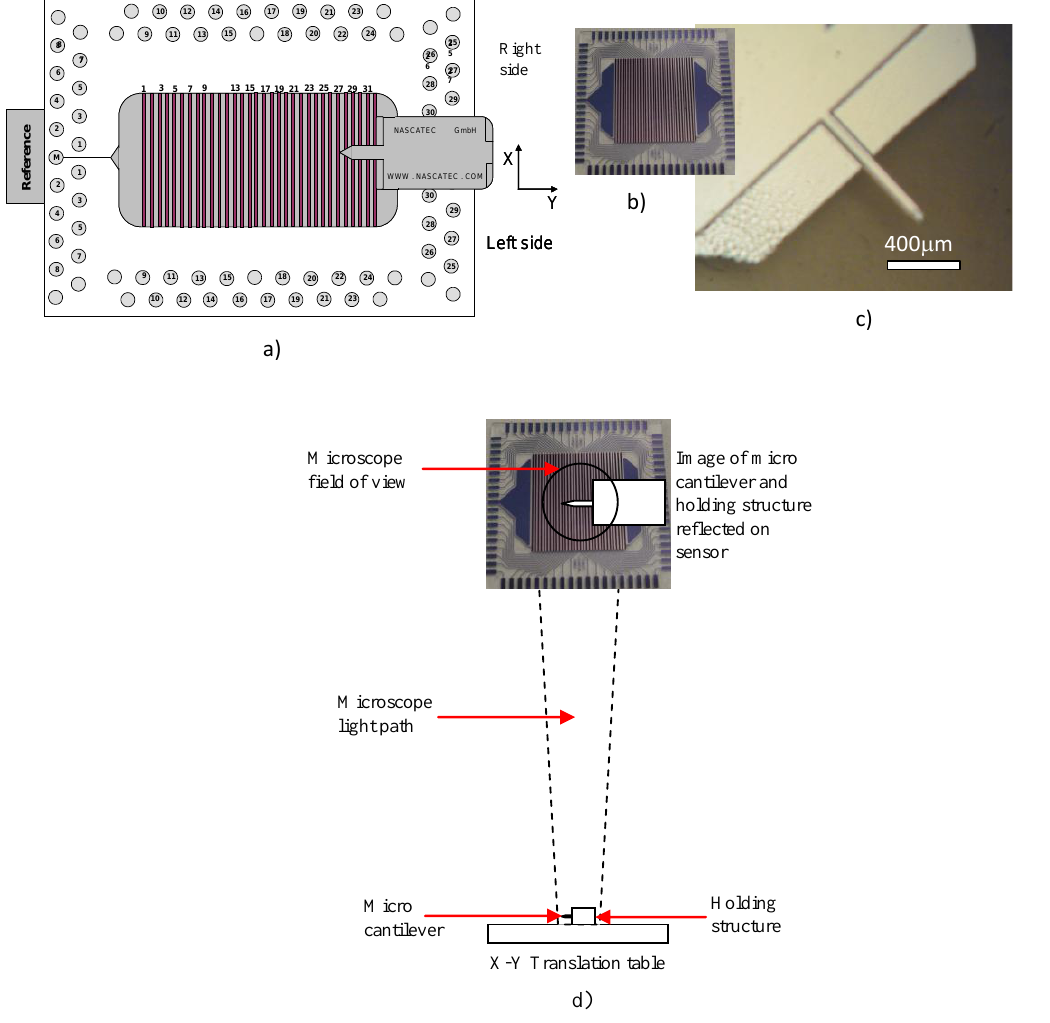
Figure 1. (a) Sketch of the 32 PSD sensor with appropriate line numbering (b) Photograph of the 32 PSD sensor (c) Photograph of the micro cantilever and its holding structure (d) Sketch of the light path, sensor, micro cantilever and reflected image